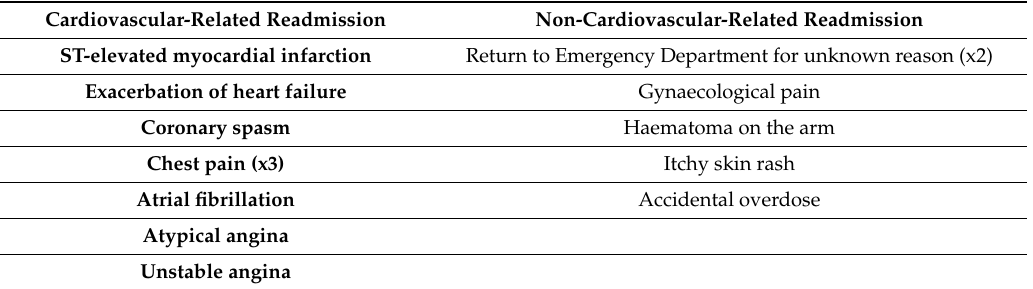
Table A7. Causes of